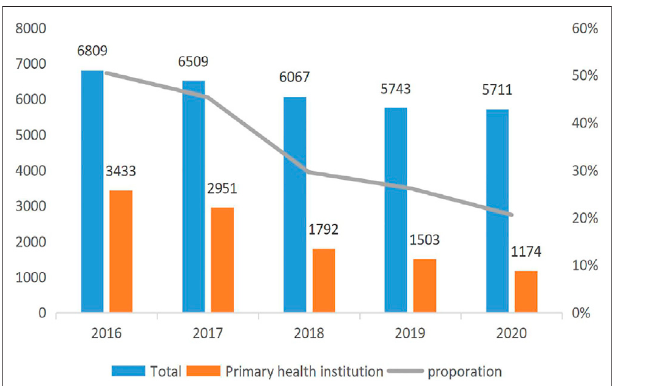
FIGURE 3 | Severity report in different levels From 2016 to